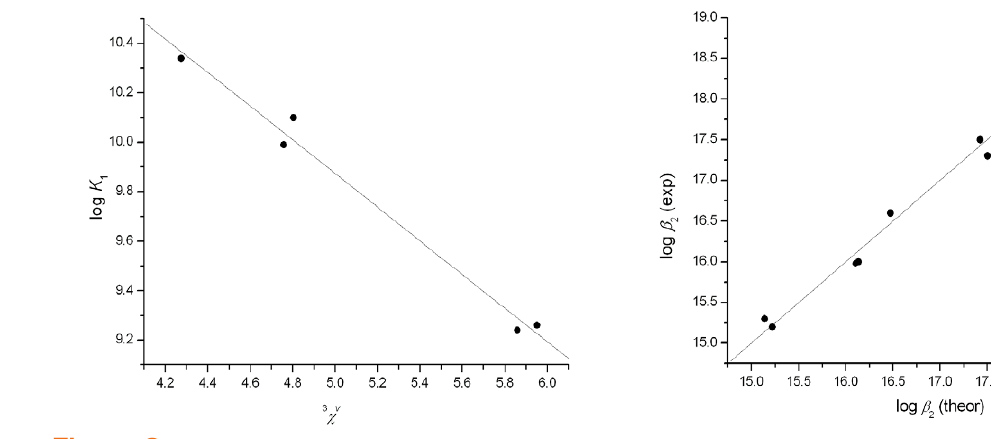
Figure 5. Experimental vs. theoretical (Eq. 5) log β and Zn(II) bis -complexes with salicylidene amino acids (Model 9, Table 2).